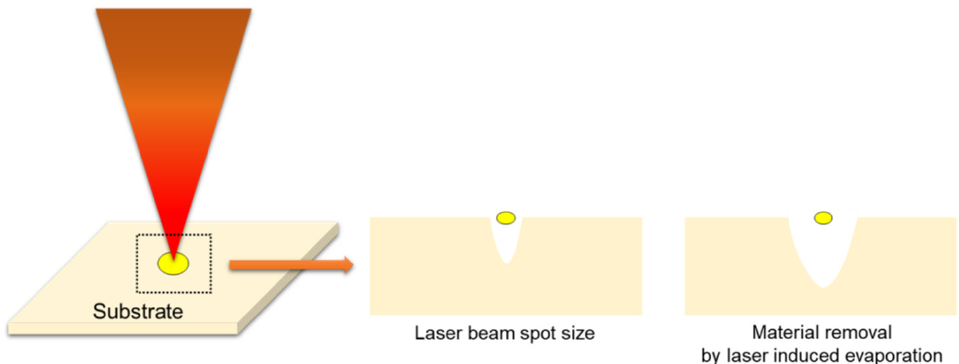
Figure 1. Schematic illustration of laser spot cutting process.